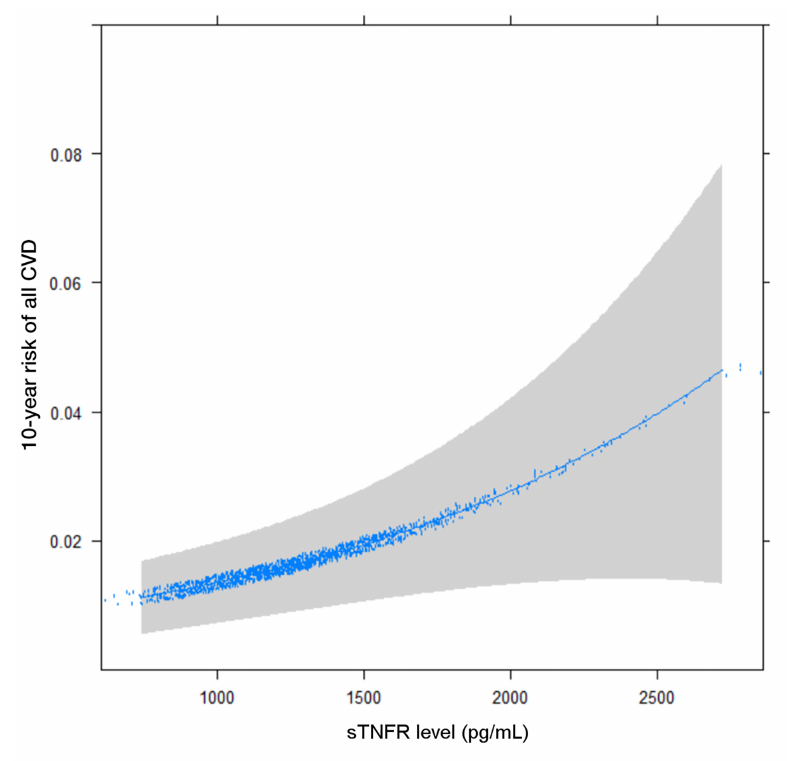
Figure 2. 10-year CVD risk by sTNFR-1 levels, adjusted for Framingham Risk Score.